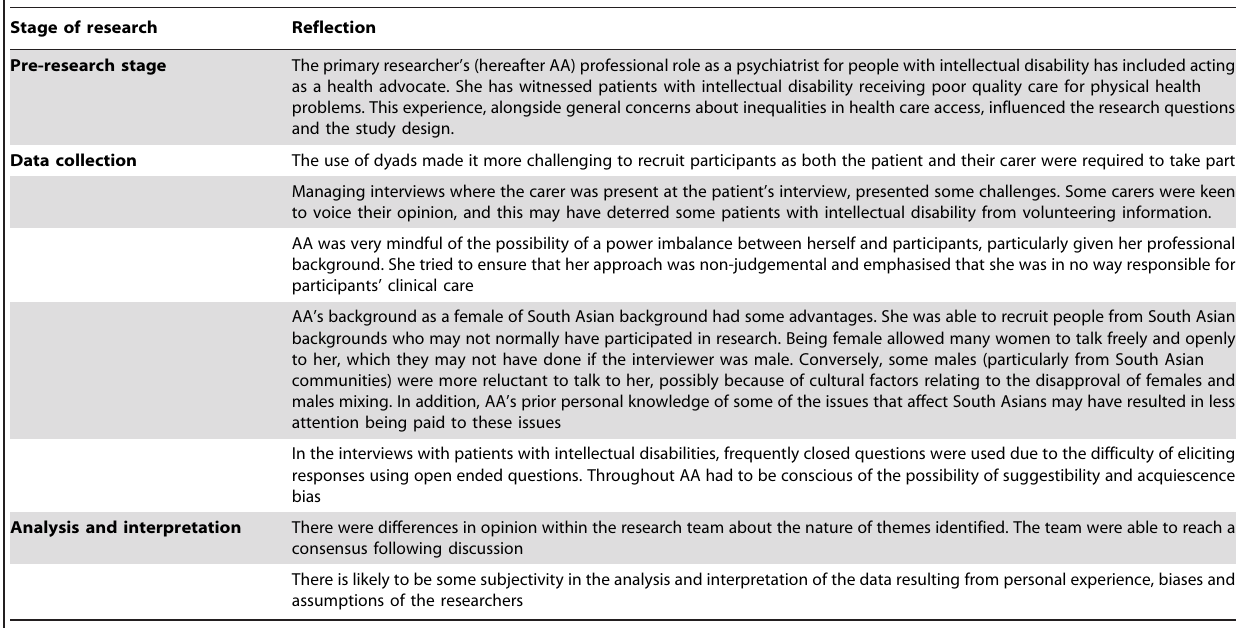
Table 6. Reflections about the conduct of the